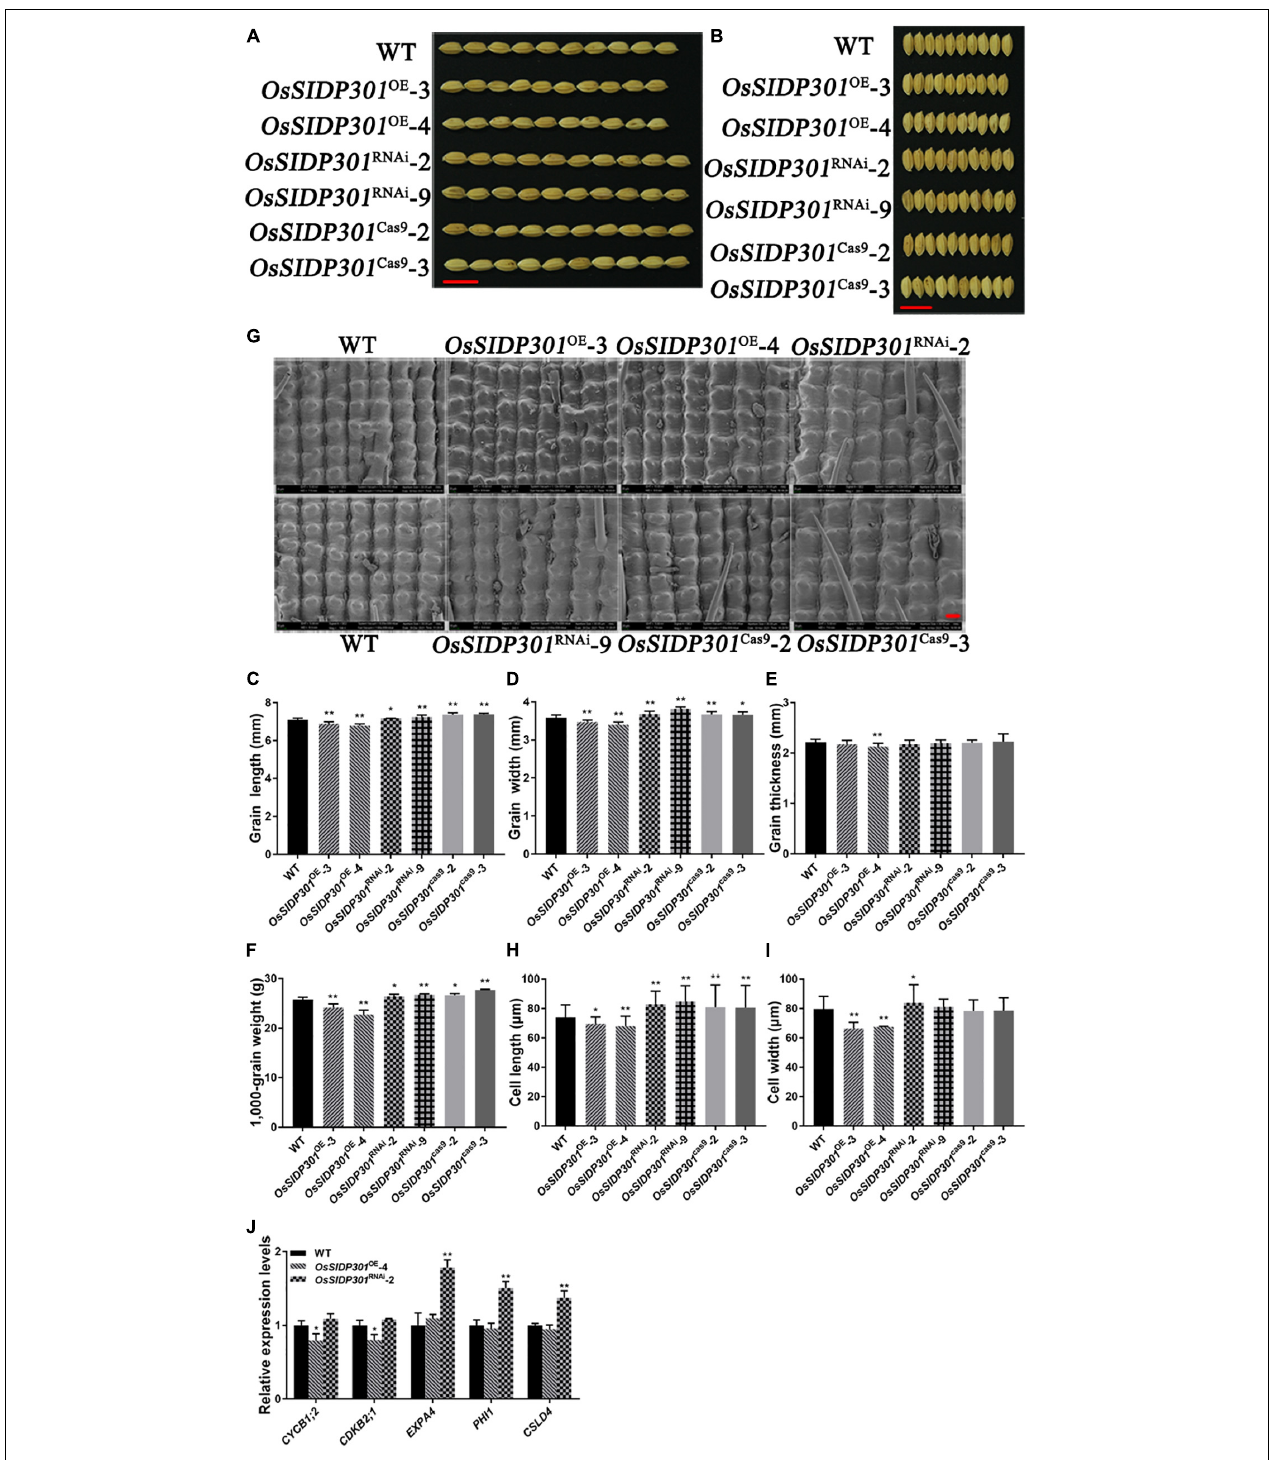
FIGURE 8 | OsSIDP301 regulates grain length and grain width. Morphology of grain length (A) and grain width (B) in WT, OsSIDP301 OE , OsSIDP301 RNAi lines, and mutants, bar = 1 cm. Comparisons of grain length (C) , grain width (D) , grain thickness (E) , and 1,000-grain weight (F) between WT, OsSIDP301 OE , OsSIDP301 RNAi , and mutants ( n = 100). (G) Scanning electron micrographs of the local outer surfaces of glumes in WT, OsSIDP301 OE , OsSIDP301 RNAi , and mutants, bar = 40 µ m. Comparisons cell length (H) and cell width (I) between WT, OsSIDP301 OE , OsSIDP301 RNAi , and mutants on the surfaces of glumes. (J) Relative expression levels of cell cycle-related and cell expansion-related genes from RNA-seq analysis in WT and transgenic lines. Data are shown as mean ± SD ( n = 3), Student’s t -test was used, * P < 0.05, ** P < 0.01.